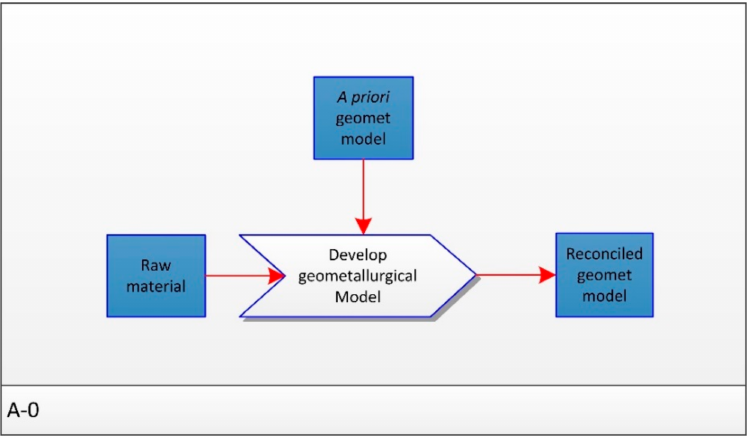
Figure 3. Geometallurgical flowsheet on a most general A-0 level.